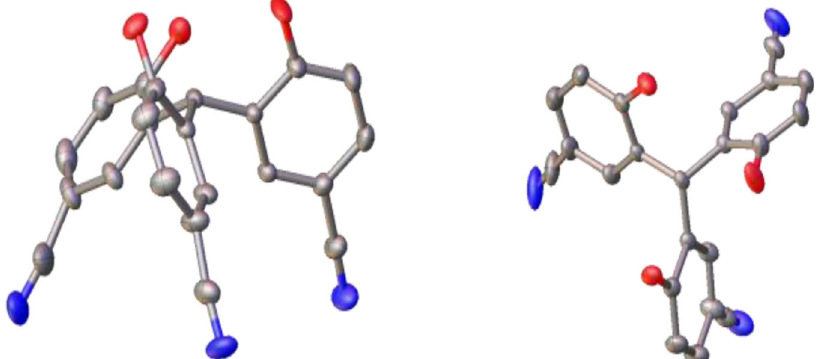
Fig. 3 Molecular structure of 1d. The compound was obtained as single crystal and the structure elucidated through single crystal X-ray analysis (ellipsoids drawn at the 50% probability level, side view (left) and top view (right), Red: O, Gray: C, Blue: N, hydrogen atoms omitted for